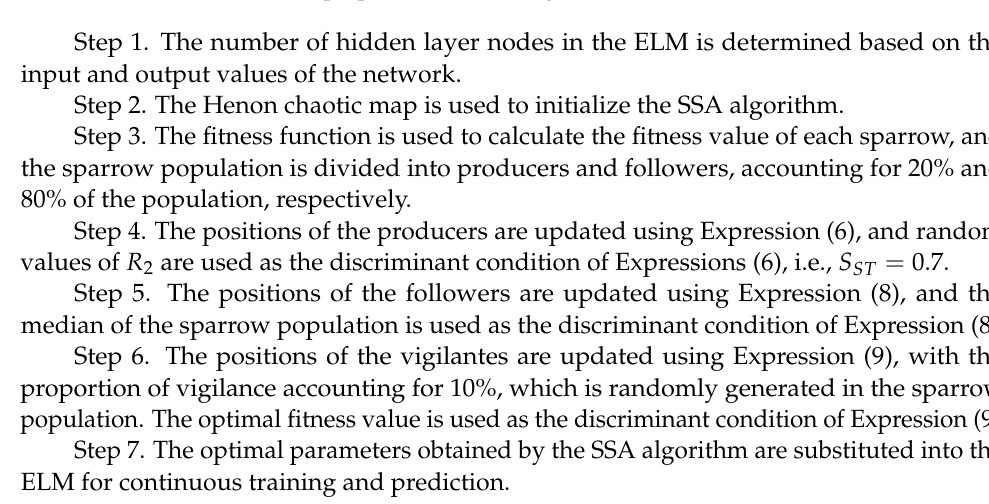
Figure 2. The workflow of the proposed SSA-ELM algorithm.